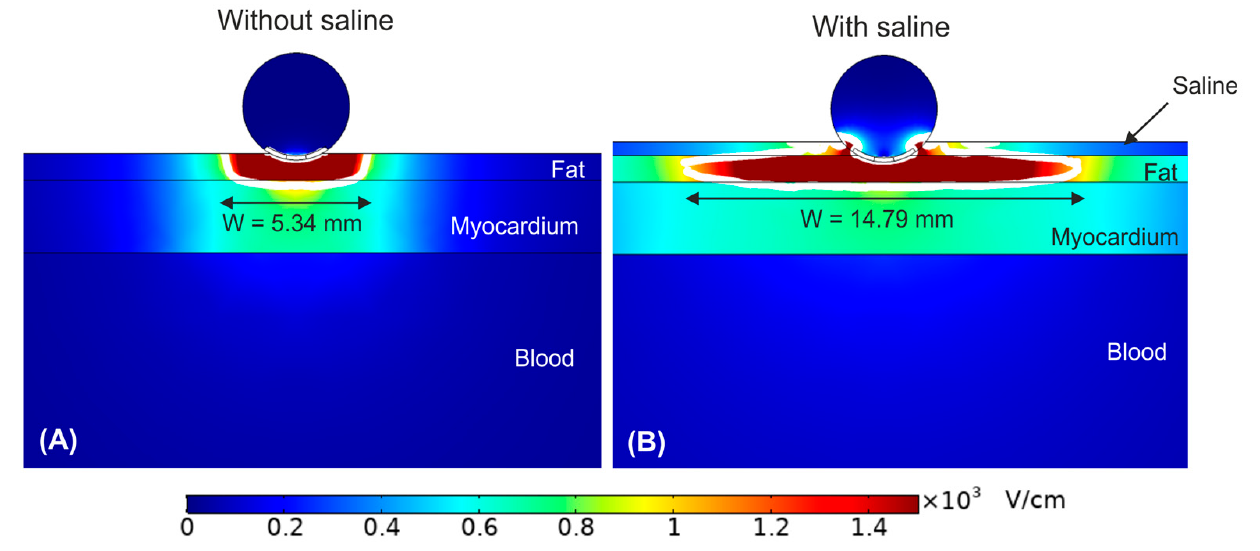
Figure 2. Electric field distribution around the target site (epicardium) for the case without ( A ) and with ( B ) a saline layer. The electrode is inserted 0.25 mm in the fat layer. The white contour corresponds to the 1000 V/cm electric field isoline.